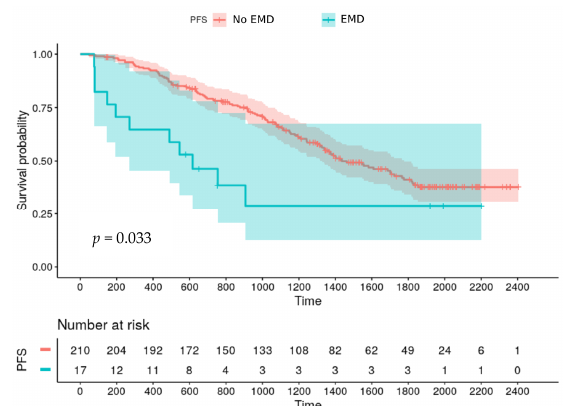
Figure 1. Progression free survival according to EMD at baseline.